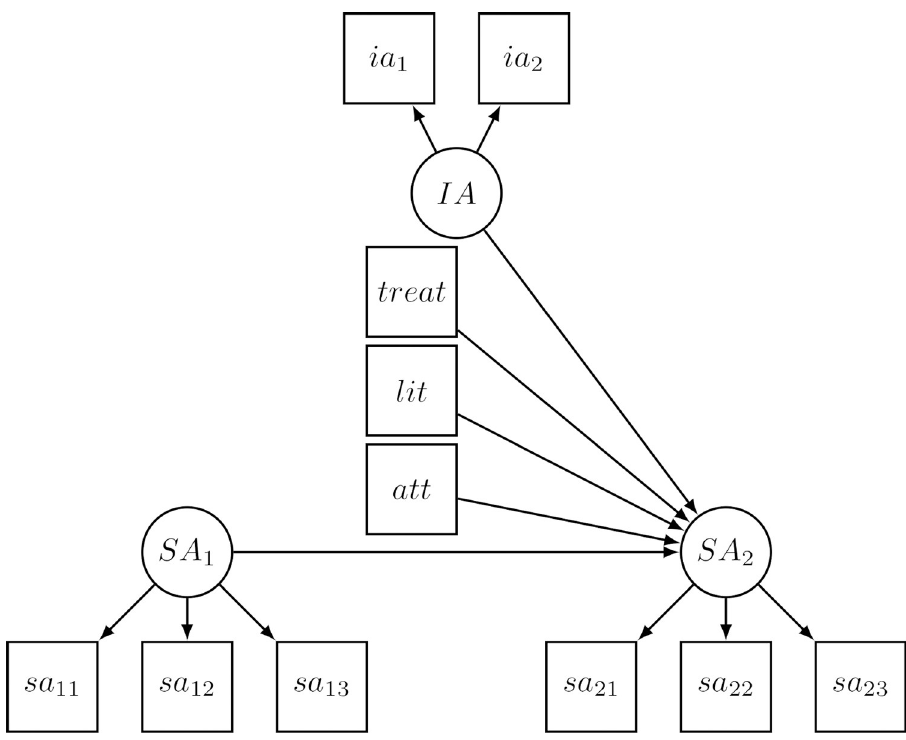
Fig 2. Computed structure model for one dependent variable (i.e., selective attention, models on reflective thought, and theory–practice integration structured accordingly). SA : Latent variable “selective attention” in pretest ( SA ) as a control variable and posttest ( SA ) as the dependent variable; sa : Manifest variables of “selective attention” 1 2 representing the three vignettes within each measurement point; att : Attendance; lit : Theoretical literature on classroom management; treat : Treatment; IA : Latent variable of instructors’ attitudes about the treatment; ia : Manifest variables of instructors’ attitudes.